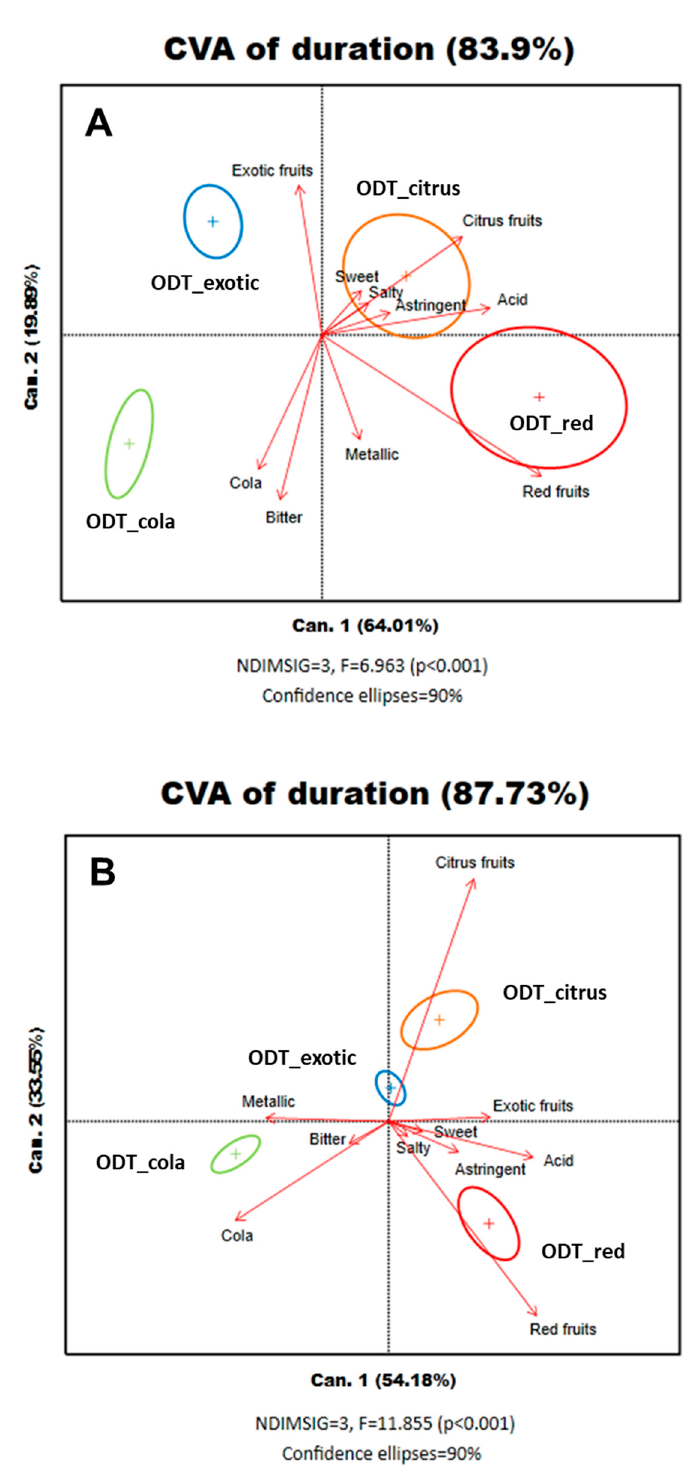
Figure 3. ( A ) TDS (Temporal Dominance of Sensations) product map discriminating the four products using CVA (Canonical Variate Analysis). Colored ellipses represent the products: blue, ODT_exotic; green, ODT_cola; red, ODT_red; and orange, ODT_citrus. The attribute names are in black, and attributes are represented by red vectors. ( B ) TCATA (Temporal Check-All-That-Apply) product map discriminating the four products using CVA analysis. Color ellipses represent the products: blue, ODT_exotic; green, ODT_cola; red, ODT_red; and orange, ODT_citrus. The attribute names are in black, and attributes are represented by red